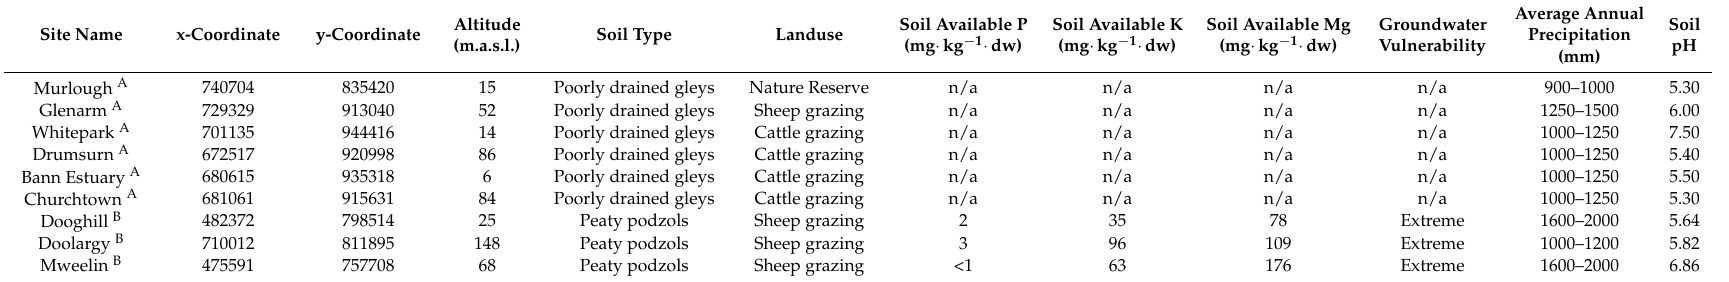
Table 1. Study site locations and